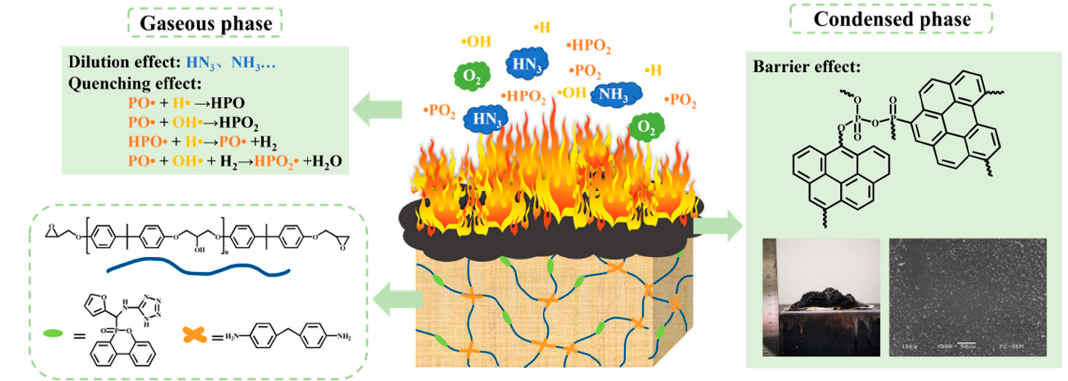
Figure 5. A possible flame-retardant mechanism for FREPs.